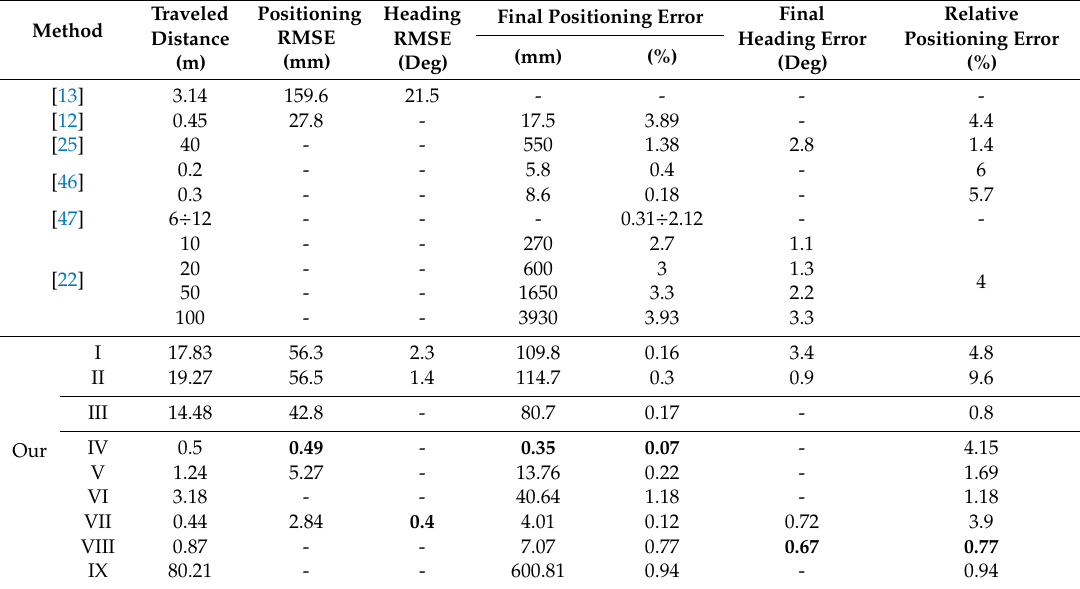
Table 2. Quantitative results of discussed experiments compared with the methods of the state of art. The best values for each estimate are in